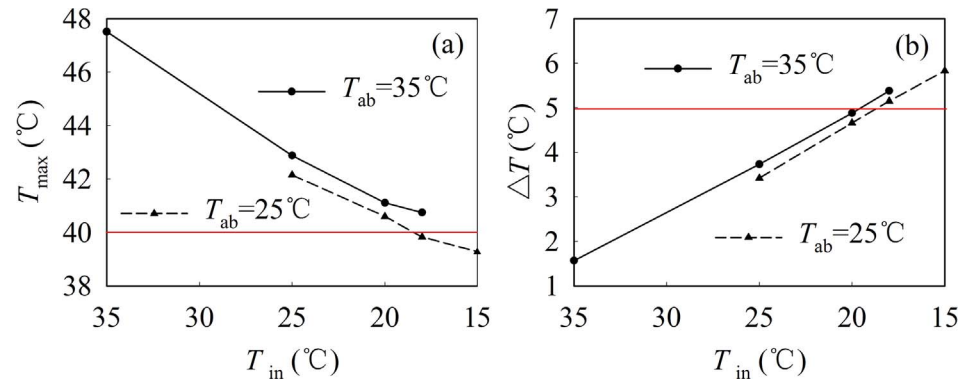
Figure 7. ( a ) T max and ( b ) ∆ T of a battery under different inlet coolant temperatures with an input power of 40 W and flow rate of 2 LPM (from Liang et al. [39], with permission from Elsevier).